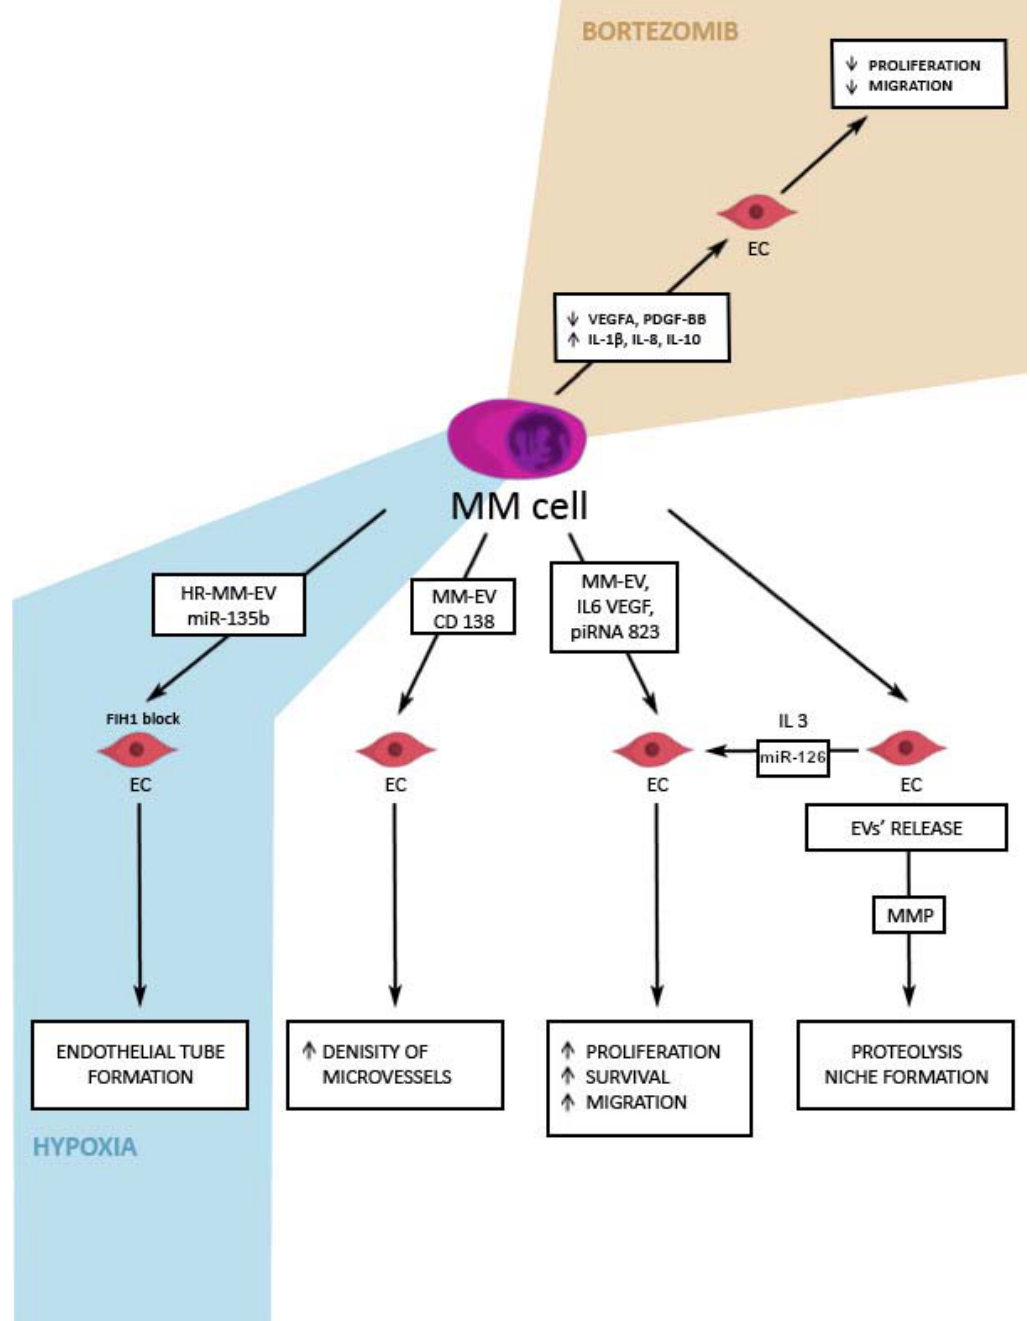
Figure 2. EVs’ involvement in the process of angiogenesis. MM-EVs interact with ECs and promote angiogenesis and hence, the further survival of tumor cells. MM-EVs’ component, piRNA-823, incorporated by the endothelial cells, could increase the level of VEGF and IL-6 and therefore, lead to the increased proliferation, survival, and migration of endothelial cells. A surface molecule of MM-EVs, CD138, could interact with ECs—its gene expression is correlated with the density of the microvessels in the stages of MM and MGUS. Different conditions alter the composition of MM-EVs. MM-EVs exposed to hypoxia contain miR-135b, which blocks FIH1 in the endothelial cells and hence, leads to the endothelial tube formation (blue background in the figure). MM-EVs pretreated with bortezomib (proteasome inhibitor used in the treatment of multiple myeloma) (beige background in the figure), contained lower amounts of the pro-angiogenic factors (VEGFA, PDGF-BB, uPAR) and higher